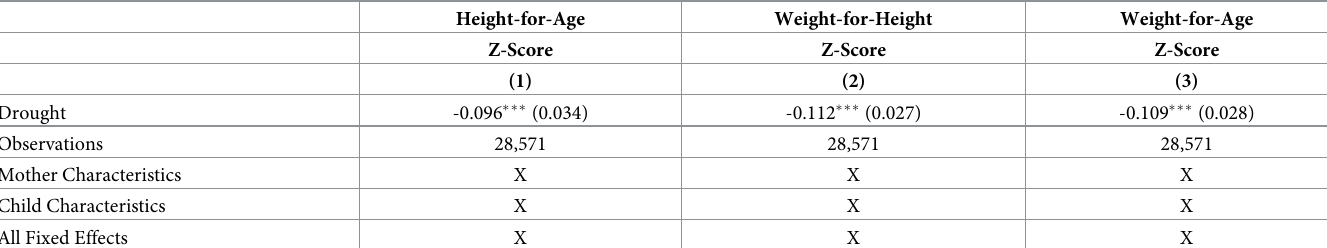
Table 1. Prenatal exposure to droughts and child health—Main results.